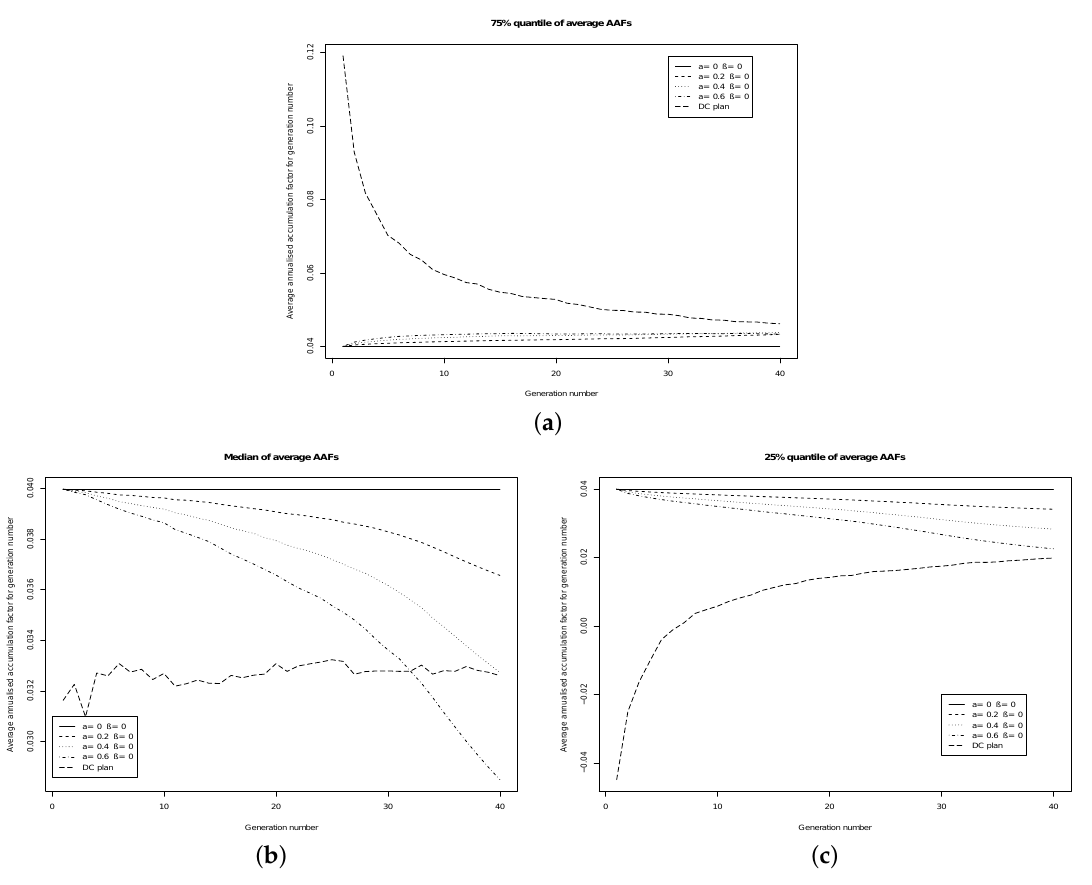
Figure 1. The average AAF for each generation in the model, as the investment risk adjustment ( a ) is varied and the AAF adjustment ( b ) is set equal to zero. The target funding level is ¯ F = 100%. In this simple membership, each of the 40 members starts with $1 at time 0, and makes no further contribution. ( a ) 75% quantile, ¯ F = 100%; ( b ) Median, ¯ F = 100%; ( c ) 25% quantile, ¯ F =